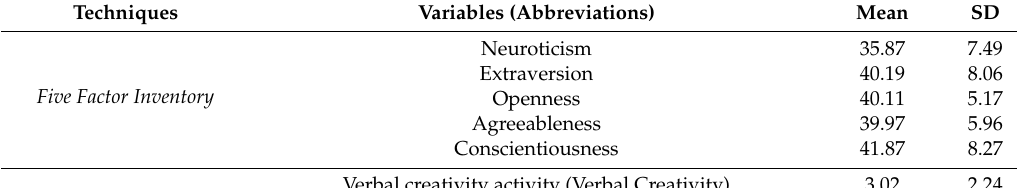
Table 1. The Means and Standard Deviations (SD) of all Studied Variables, raw scores.